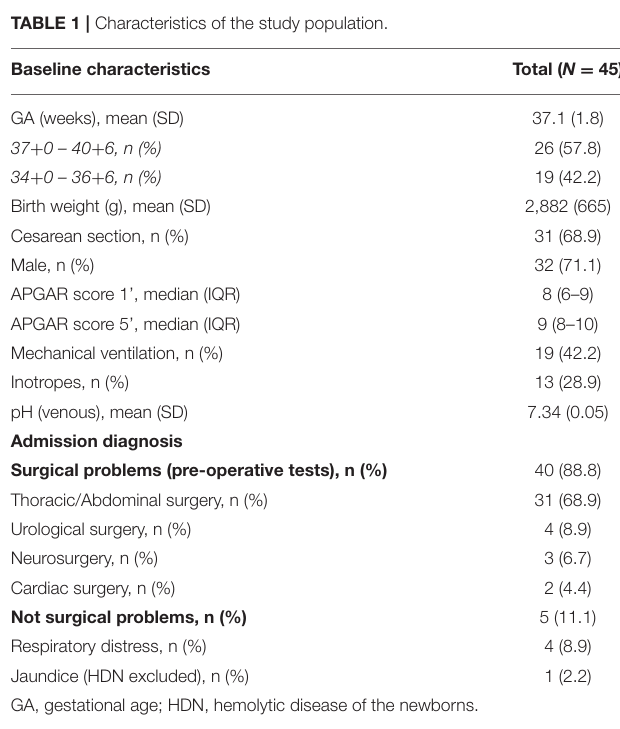
TABLE 1 | Characteristics of the study